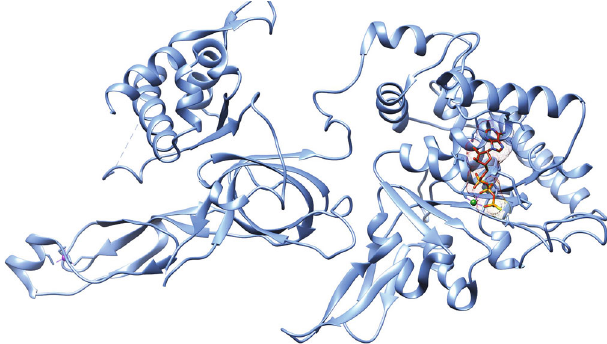
Figure 1: 3D structure of MCM7 (6XTX) integrated with AGS (red), Zn (purple), and Mn